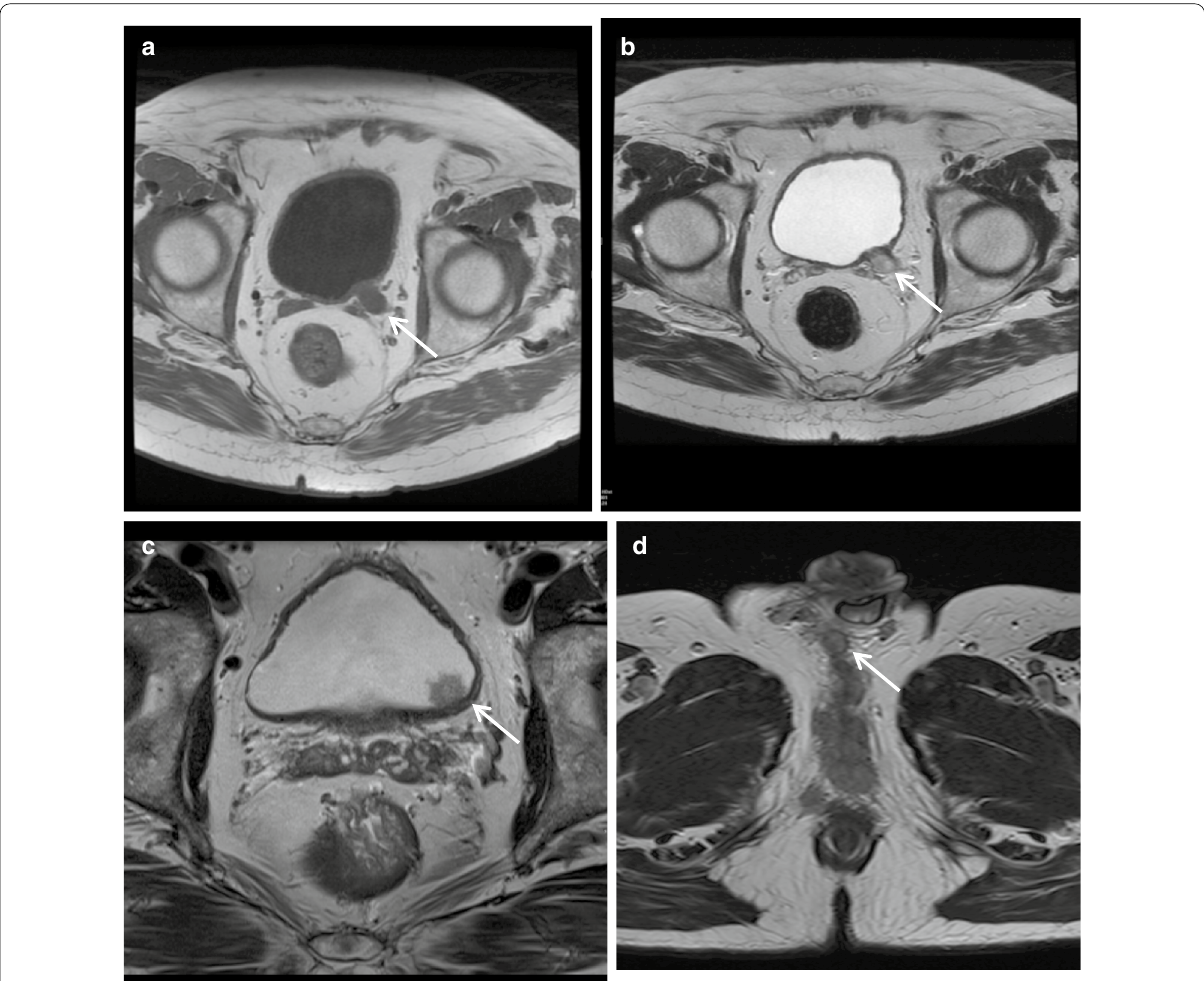
Fig. 19 Urothelial carcinoma a Axial T1W image shows a slightly T1 hypointense lesion (white arrow) compared to the gluteus maximus muscle in the left vesicoureteric junction. b Axial T2W image in the same patient shows the left VUJ filling defect which is T2 hyperintense to bladder wall and gluteal muscle. c Is an axial T2W image of a different patient showing an intermediate signal intensity polypoid lesion on the left posterior bladder wall (white arrow). d Is an axial T2W image of yet another patient with a history of urothelial carcinoma showing multiple ill-defined, T2 hyperintense to gluteus muscle, nodules in the perineum and extending to the ventral aspect of the penis in keeping with metastases (white arrow)